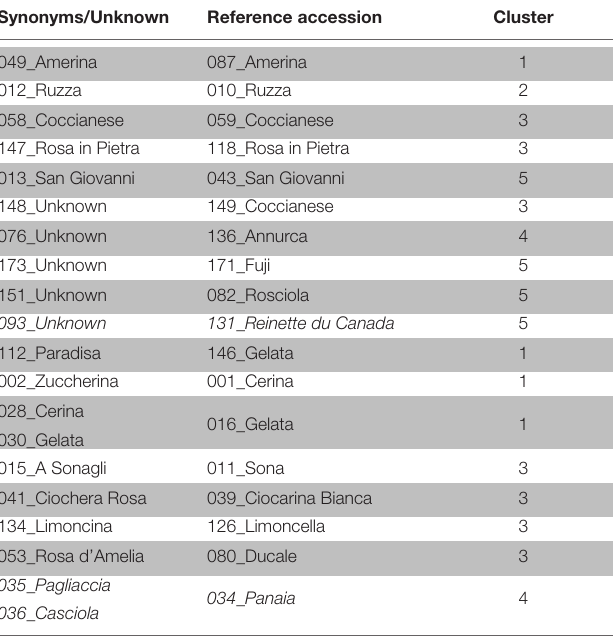
TABLE 4 | Accessions with identical SSR profile at 19 loci , used to identify unknown accessions and synonyms ∗ .